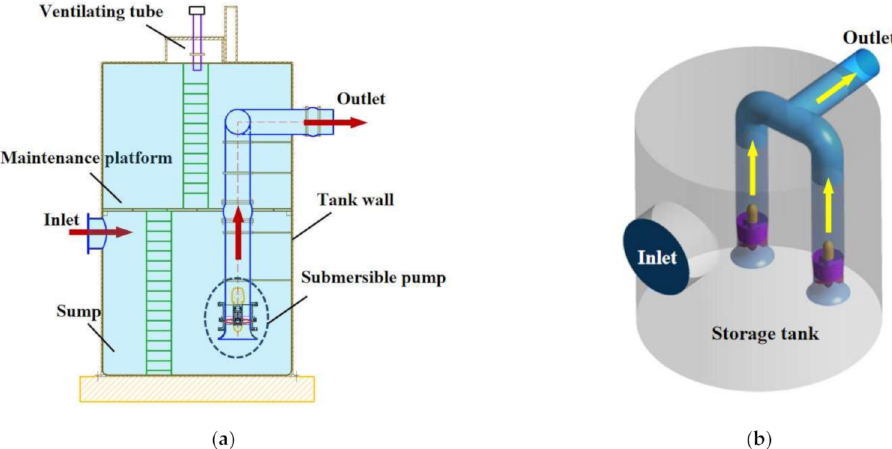
Figure 1. A typical prefabricated pumping station: ( a ) Schematic diagram of main components; ( b ) Three-dimensional